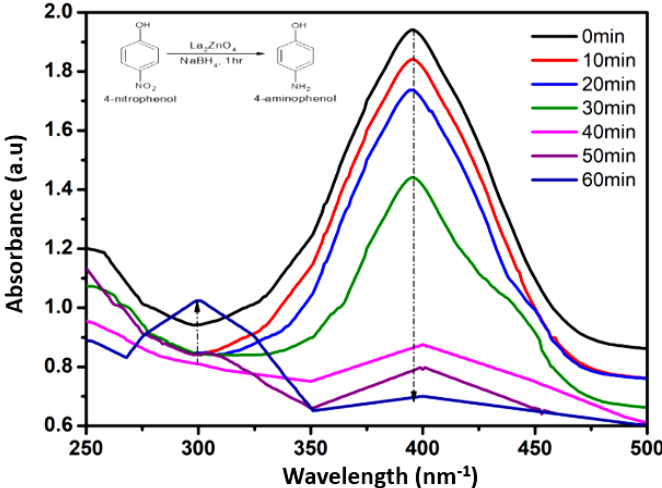
Figure 7. Photocatalytical reduction of 4-nitophenol into